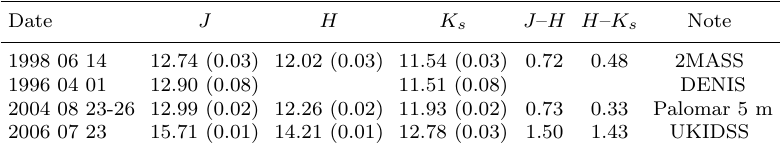
Table 2. Near infrared